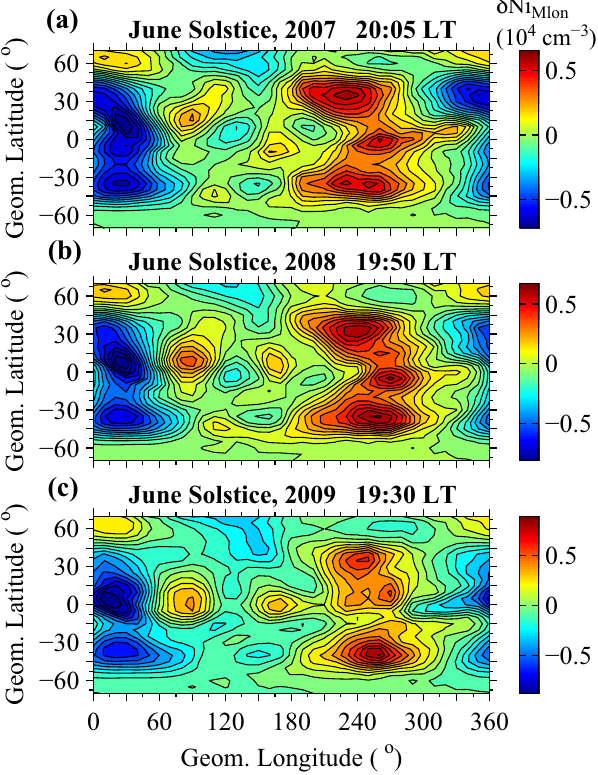
Fig. 7. Same as Figure 1c but for DMSP F16 nightside measure- ments around the June Solstice during the deep solar minimum of 2007 – 2009. The local time when the DMSP F16 satellite was over the equator is labeled at the top of each